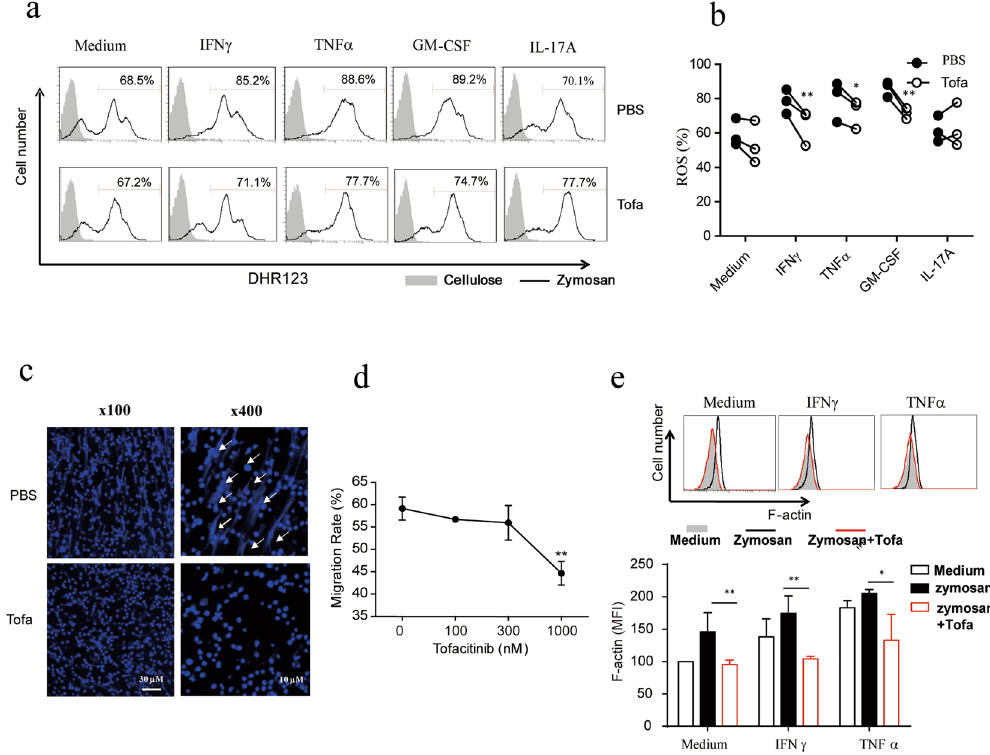
Figure 4. Effect of tofacitinib on the activation and function of human PMNs. ( a , b ) Freshly isolated human PMNs were treated with IFN γ (10 ng/ml), TNF α (200 U/ml), GM-CSF (10 ng/ml) or IL-17A (10 ng/ml) in the presence, or absence, of tofacitinib (1 μ M) for 2 h, followed by DHR123 loading and stimulation with zymosan (50 μ g/ml). ROS production was evaluated by detecting fluorescence-converted DHR123 in the cells using a FACS machine. Representative results using blood samples from one donor are shown as histograms, peaks representing ROS-positive cells are indicated by red bars ( a ). Repeating results using samples from 3 unrelated donors were individually converted into percent ROS-positive cells for statistical comparison between groups treated with PBS (filled circle) or tofacitinib (open circle) ( b) . Each pair of filled and open circles represents data from one donor. * p < 0.05, ** p < 0.01. For NET formation assay ( c ), freshly isolated human PMNs were stimulated with with zymosan (50 μ g/ml) for 4 h, followed by followed by 4% PFA fixation and DAPI staining. Images were acquired by confocal microscopy at 100x and 400 magnifications. Arrows indicate traps (NETs) formed. For leukocyte migration assay ( d ), human PMNs were incubated with different concentrations of tofaicitinib for 2 h in the top chamber of a transwell system, then fMLP (100 nM) was in the bottom chamber and allowed a further 2 h incubation. After fixation and DAPI staining steps, migrated cells were counted, and the results are shown as ratio of migration, calculated as 100 × (migrated cell number/starting cell number). ** p < 0.01. For F-actin formation analysis ( e ), human PMNs were pre-incubated with IFN γ or TNF α in the presence, or absence, of tofacitinib (1 μ M), followed by stimulation with zymosan for 4 h, untreated cells were included as control. Aggregated F-actin in the cells was stained by fluorescence labeled phalloidin and visualized by FACS analysis. Representative histograms are shown in the upper panels and the statistic results of three independent experiments (expressed by mean fluorescence intensity of peaks) are given in the lower panel. * p < 0.05, ** p <